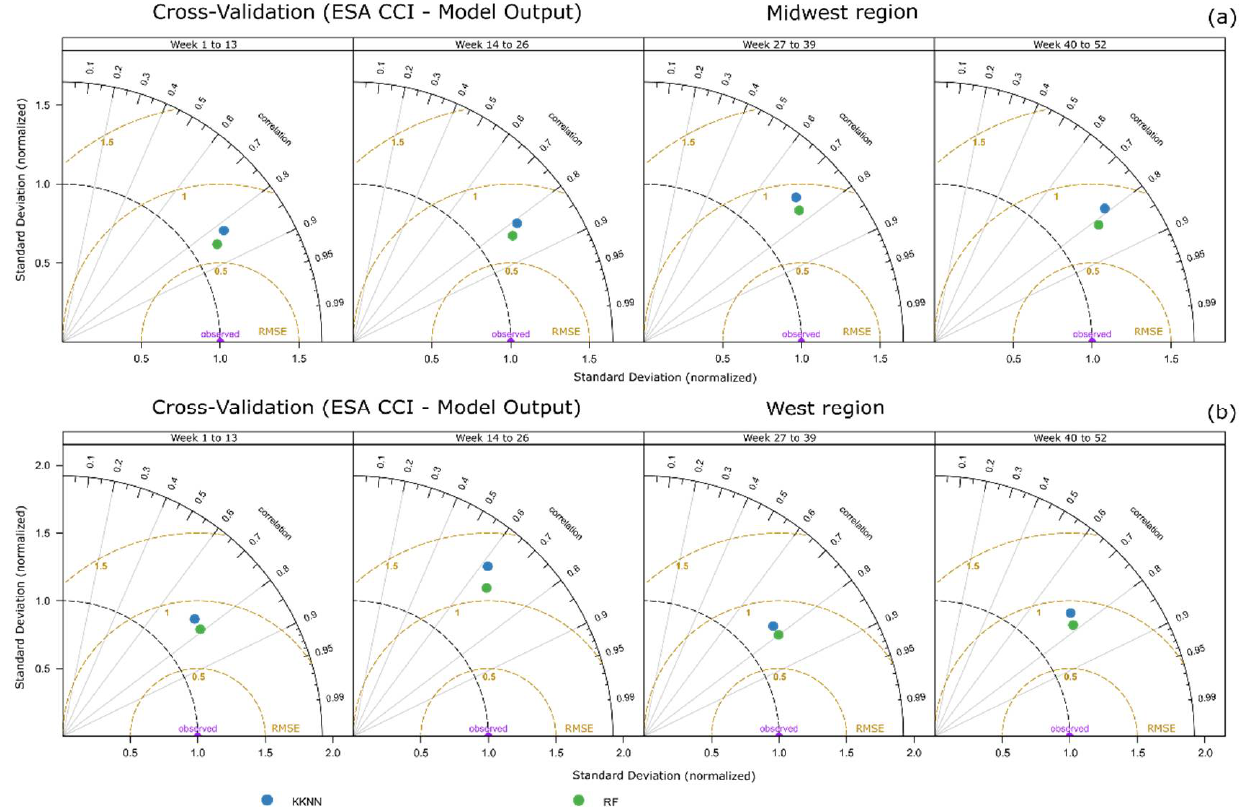
Figure 5. Taylor diagrams showing cross-validation between weekly 1 km predicted soil moisture and ESA-CCI reference data, the 52 weekly predictions are grouped in four 3-month periods; ( a ) weekly cross-validation of the Midwest ROI; ( b ) weekly cross-validation of the West ROI.